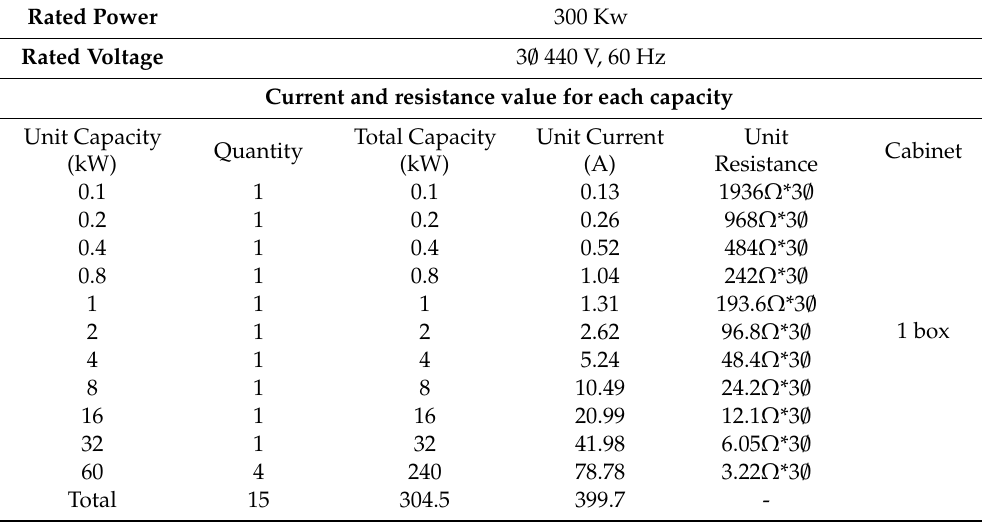
Table 5. Specification of the load bank.